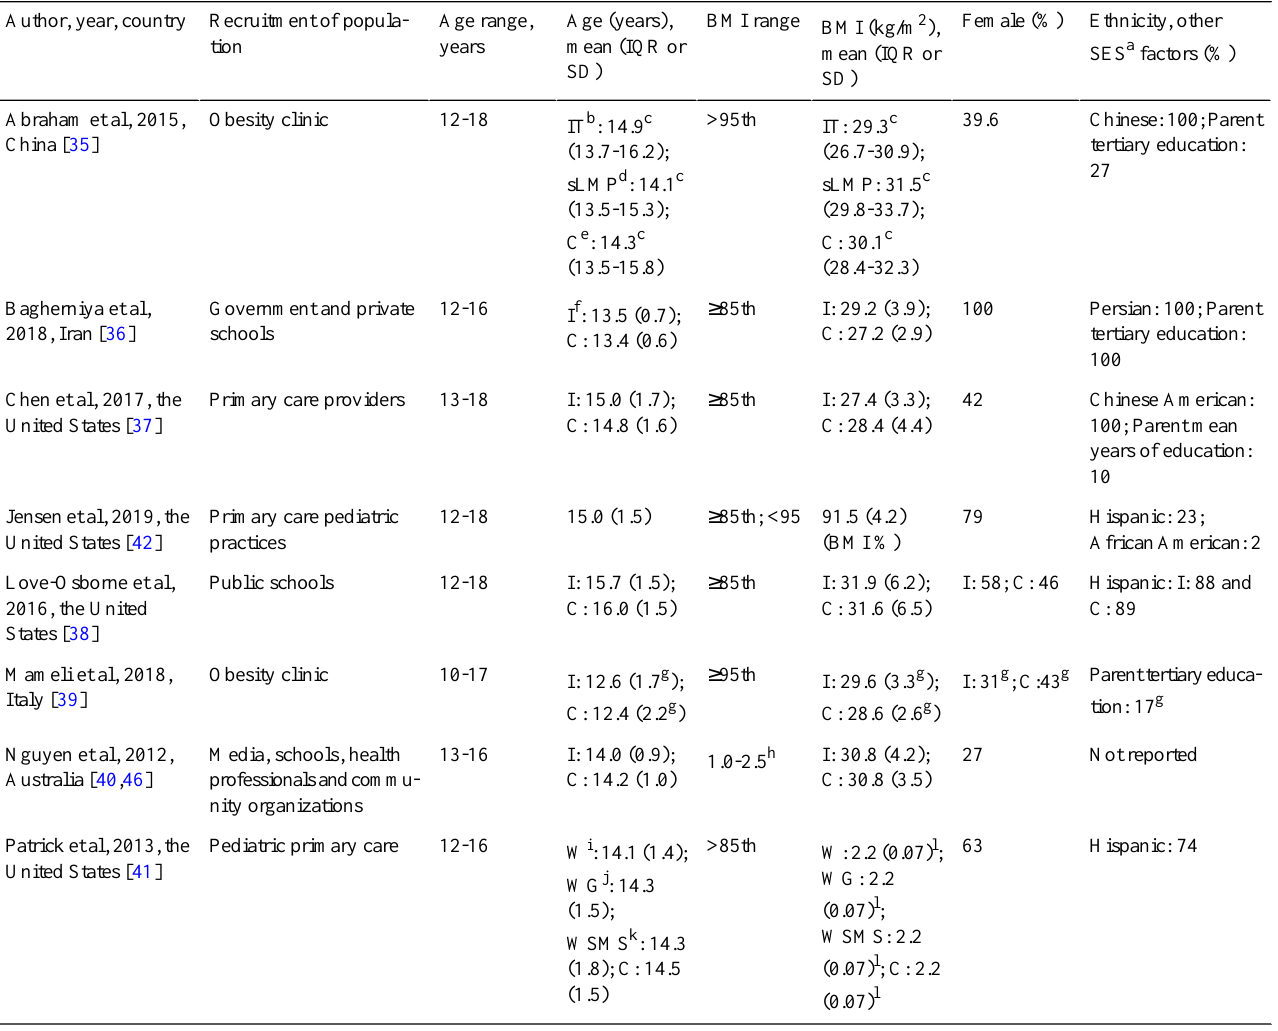
Table 5. Characteristics of participants from included studies (n=8).